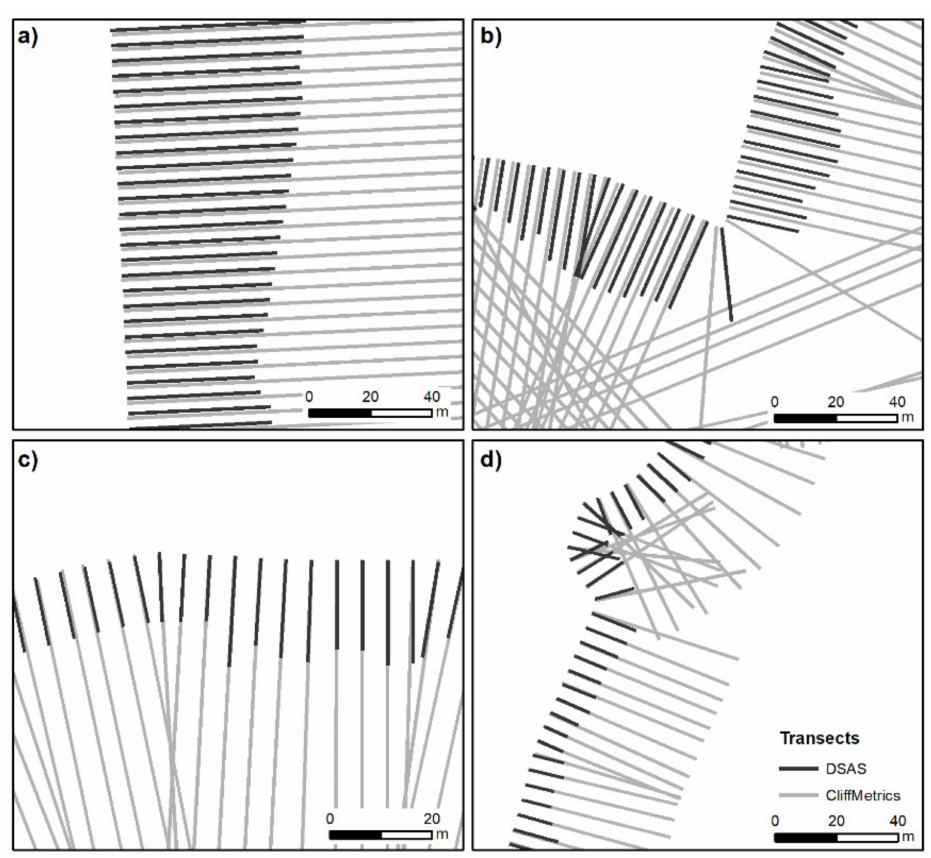
Figure 8. Examples showing DSAS and CliffMetrics normal lines: ( a ) straight coast in sector A07; ( b ) curve coast in sector A07; ( c ) coastline with small curvature in sector A03; and ( d ) curve coastline in sector A04. The DSAS transects are cut by the last shoreline available, to give a better visual interpretation.